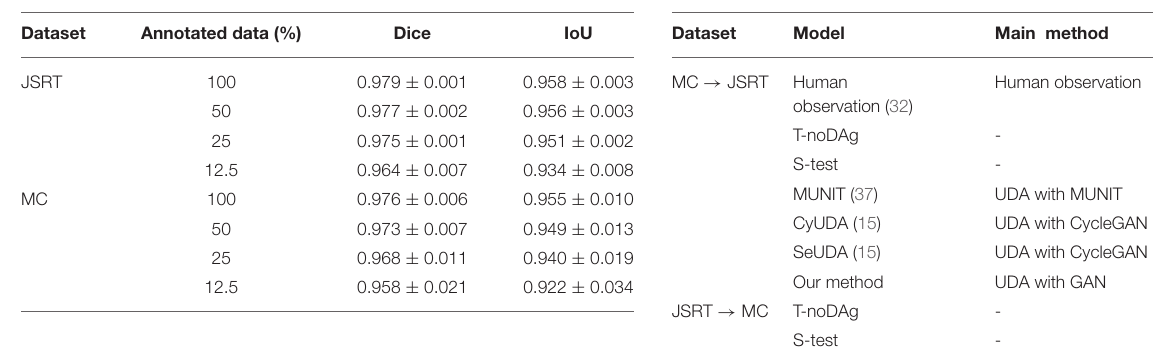
TABLE 3 | Comparison of the results of U-shaped GAN trained with different proportions of annotated data.